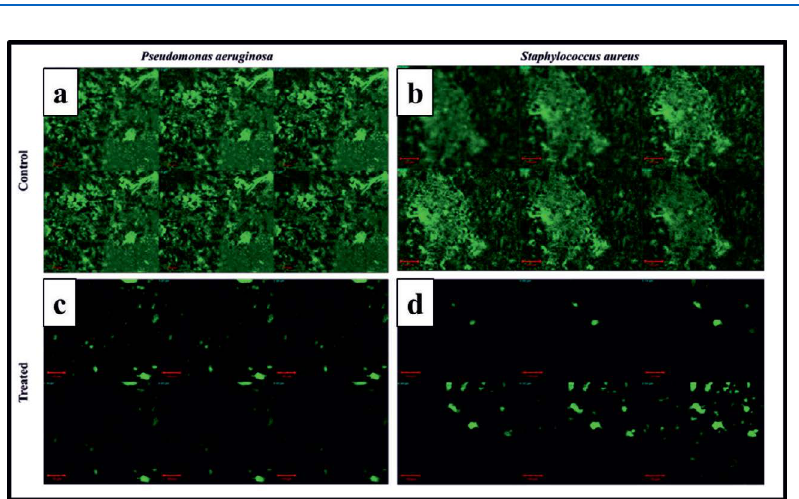
Fig. 7. (a) CLSM images of P. aeruginosa biofilm formation; (b) CLSM images of S. aureus biofilm formation; (c) CLSM images of P. aeruginosa biofilm formation treated with bioflocculant (80 µg/ml); (d) CLSM images of S. aureus biofilm formation treated with bioflocculant (70 µg/ml); Each experiment was replicated